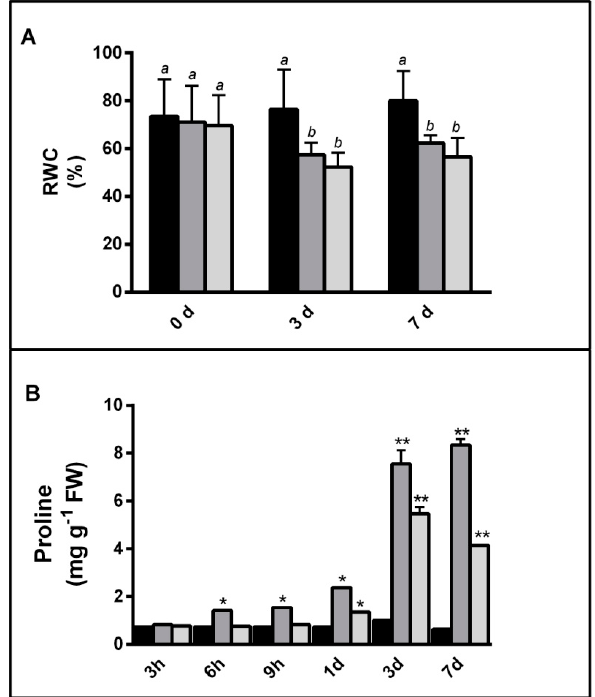
Figure 1. ( A ) The relative water content (RWC) and ( B ) Proline content, in leaves of barley ( Hordeum vulgare cv. Nure) grown under controlled conditions (black bars); salt stress (150 mM NaCl—medium grey bars) and drought (10% PEG—light grey bars) at given times. In ( A ) statistically similar data are grouped by letters a and b in the control, salt stress and drought groups, respectively. In ( B ) asterisks indicate a significance between stressed and the control plants. * = p < 0.05; ** = p < 0.001.